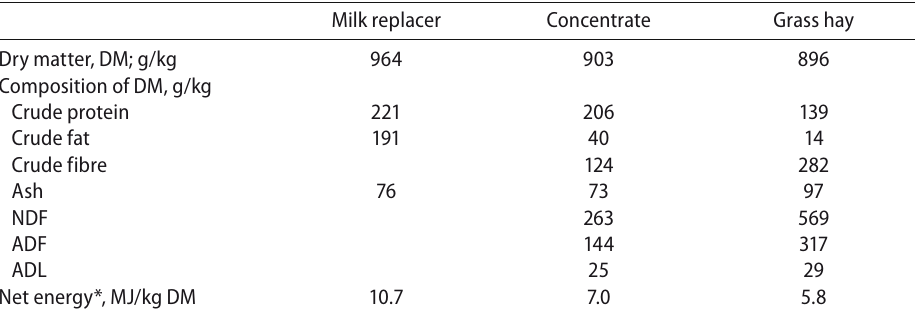
Chemical composition and energy value of the feeds fed to Belgian Blue double-muscled calves during the rearing period Milk replacer Concentrate Grass hay Dry matter, DM;